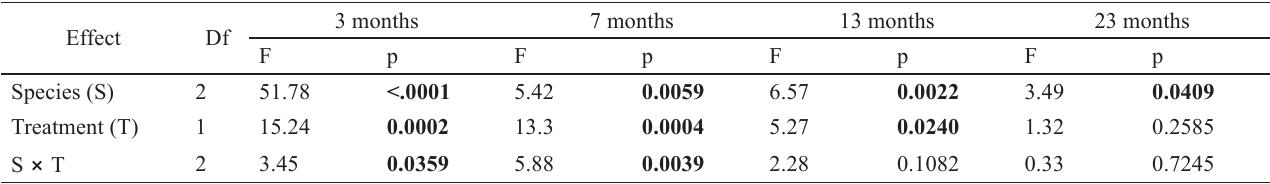
Table 1. Two-way ANOVA of the mass remaining on the effect of species, treatment, and their interaction after 3, 7, 13, and 23 months.The number of samples was 108, 108, 104, and 50 for 3, 7, 13, and 23 months, respectively. The values highlighted in bold indicate statistical significance (p < 0.05).